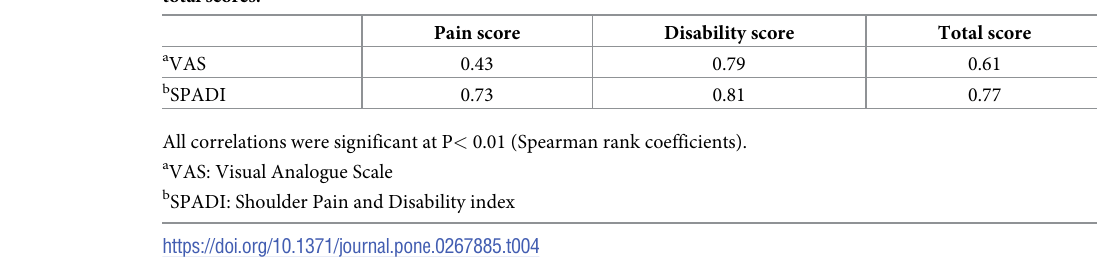
Table 4. Correlation matrix of ASST pain, disability, and total scores versus VAS, SPADI pain, disability, and total